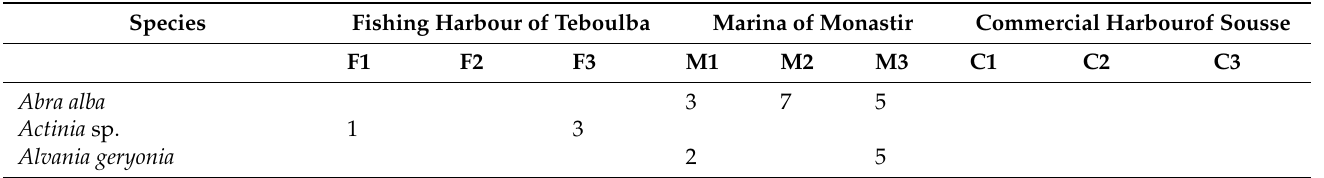
Table A2. Abundance of macrobenthic species (number of individuals per 0.2 m 2 ) in the nine stations sampled in the three harbours during spring